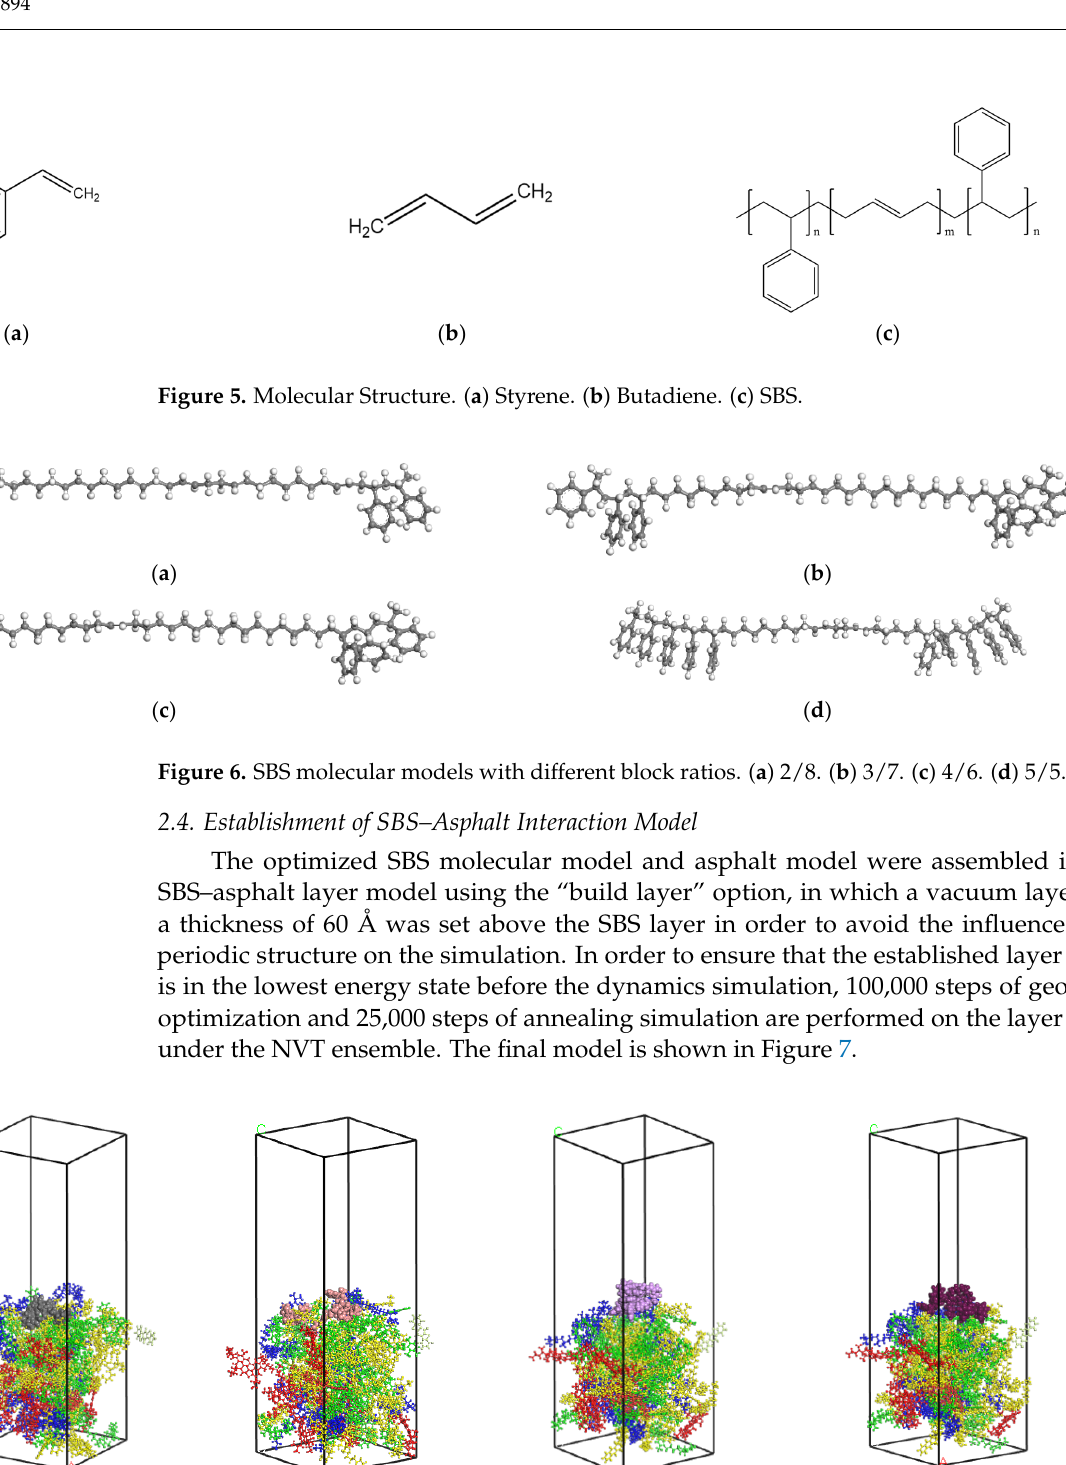
Figure 7. SBS–asphalt interaction model. ( a ) 2/8. ( b ) 3/7. ( c ) 4/6. ( d ) 5/5.